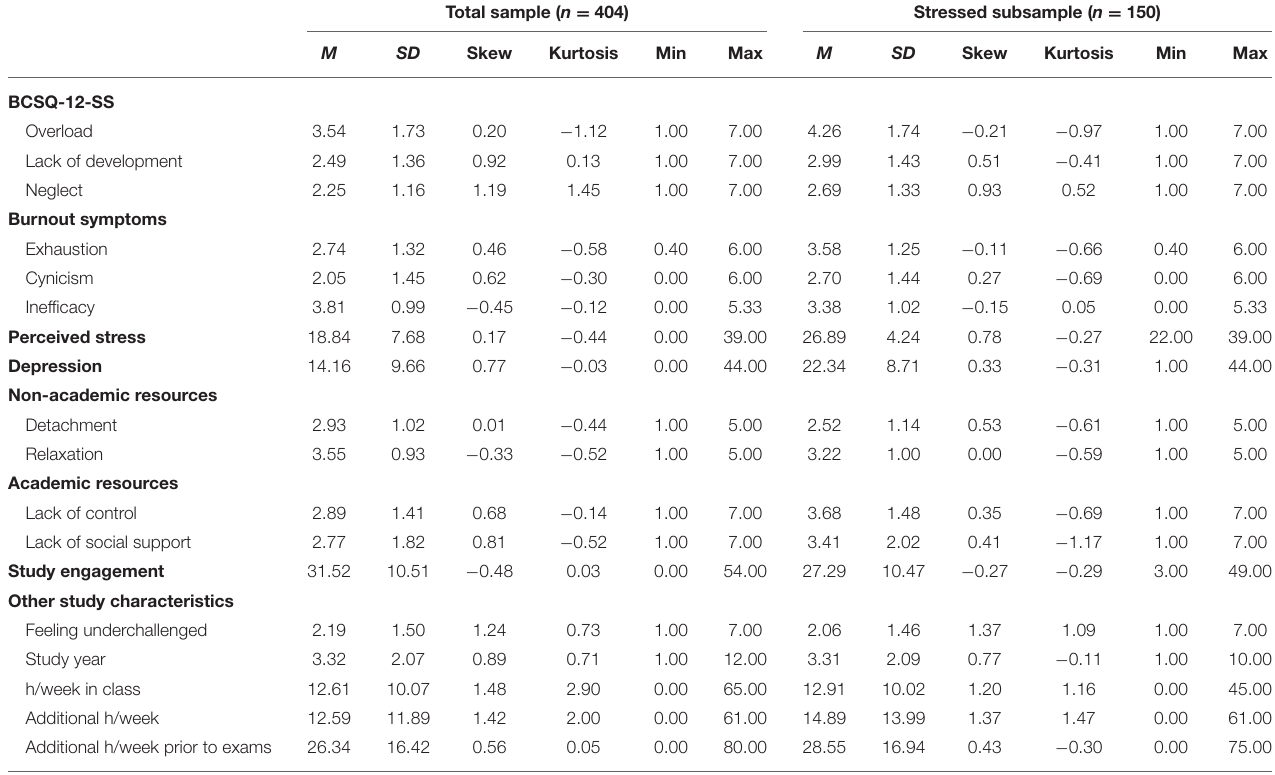
TABLE 1 | Descriptive statistics of the metric study variables.